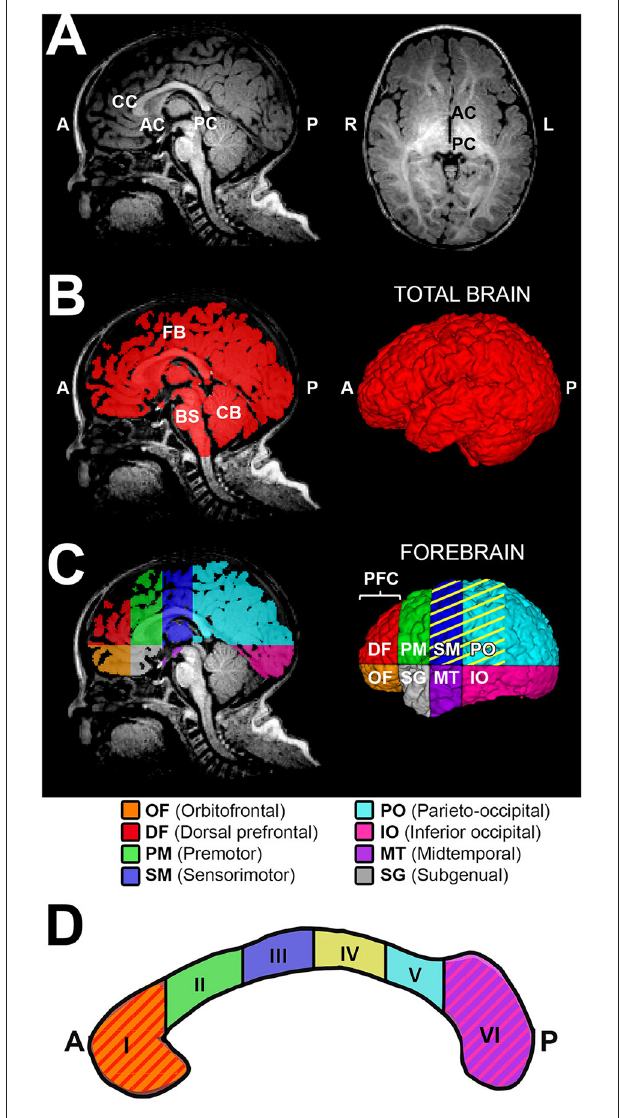
FIGURE 2 | Sub-regional forebrain analysis. T1-weighted regional forebrain analysis is shown for a term-born otherwise healthy control scanned at 7 months of age. (A) shows T1 image in midsagittal (left) and axial (right) views, noting the key anatomical landmarks used for sub-regional forebrain analysis [the anterior-most aspect of corpus callosum (CC), the anterior commissure (AC), and the posterior commissure (PC)]. Following total brain segmentation (B) , the cerebellum (CB) and brainstem (BS) were manually erased to create a mask of total forebrain. Subsequently, forebrain was parcellated into eight sub-regions (C) , as per Peterson et al. (24). Orbitofrontal (OF; orange) and dorsal prefrontal (DF; red) sub-regions were combined and analyzed as the prefrontal cortex (PFC) sub-region. Color pattern in the corpus callosum outline (D) schematically illustrates the homotopic-like relationship between different sub-regions of CC and forebrain according to existing literature (26). Specifically, CC region I (genu and rostrum) projects to PFC, region II (rostral body) projects to PM, region III (anterior midbody) projects to SM, region IV (posterior midbody) projects to SM and PO ( C , yellow stripes), region V (isthmus) projects to PO, and region VI (splenium) projects to IO and MT. The subgenual (SG) area of forebrain is predominantly comprised of limbic structures, with no major direct projections from the CC. A, anterior; L, left; P, posterior; R,